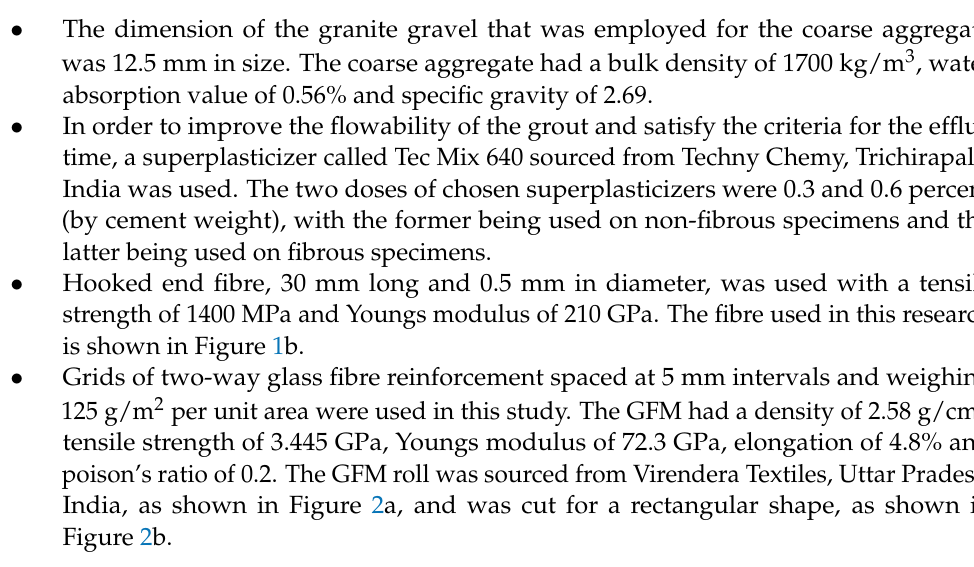
Figure 1. Appearance of fibre and prepared grout. ( a ) Cement grout and ( b ) steel fibres.